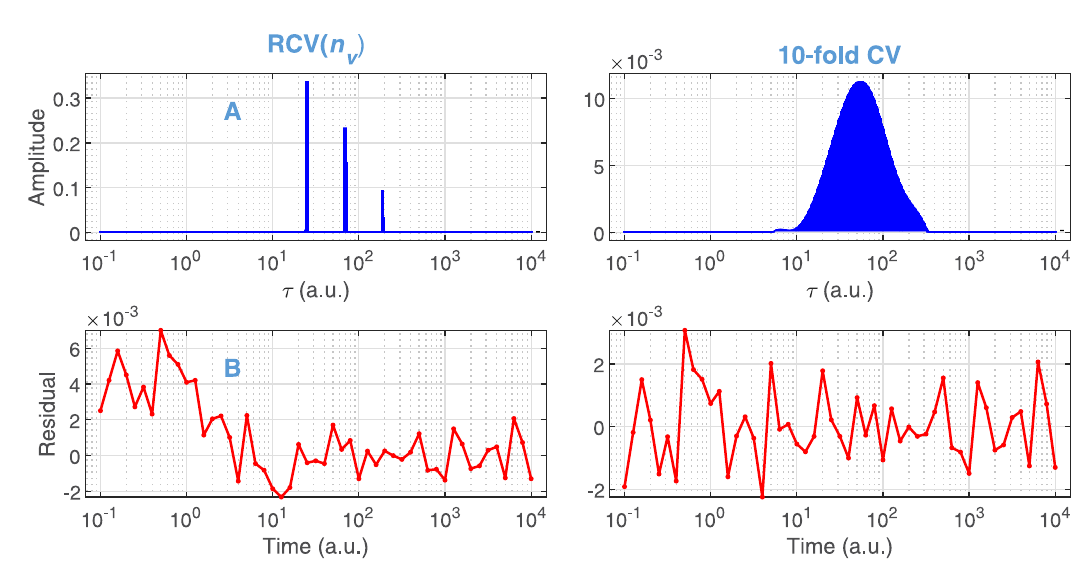
Fig 10. Solution of GENP on the selected models based on RCV(nv) and 10-fold CV presented in Fig 9. (A) Distribution of time constants. (B) The residual of the fits calculated with the distributions presented in (A).